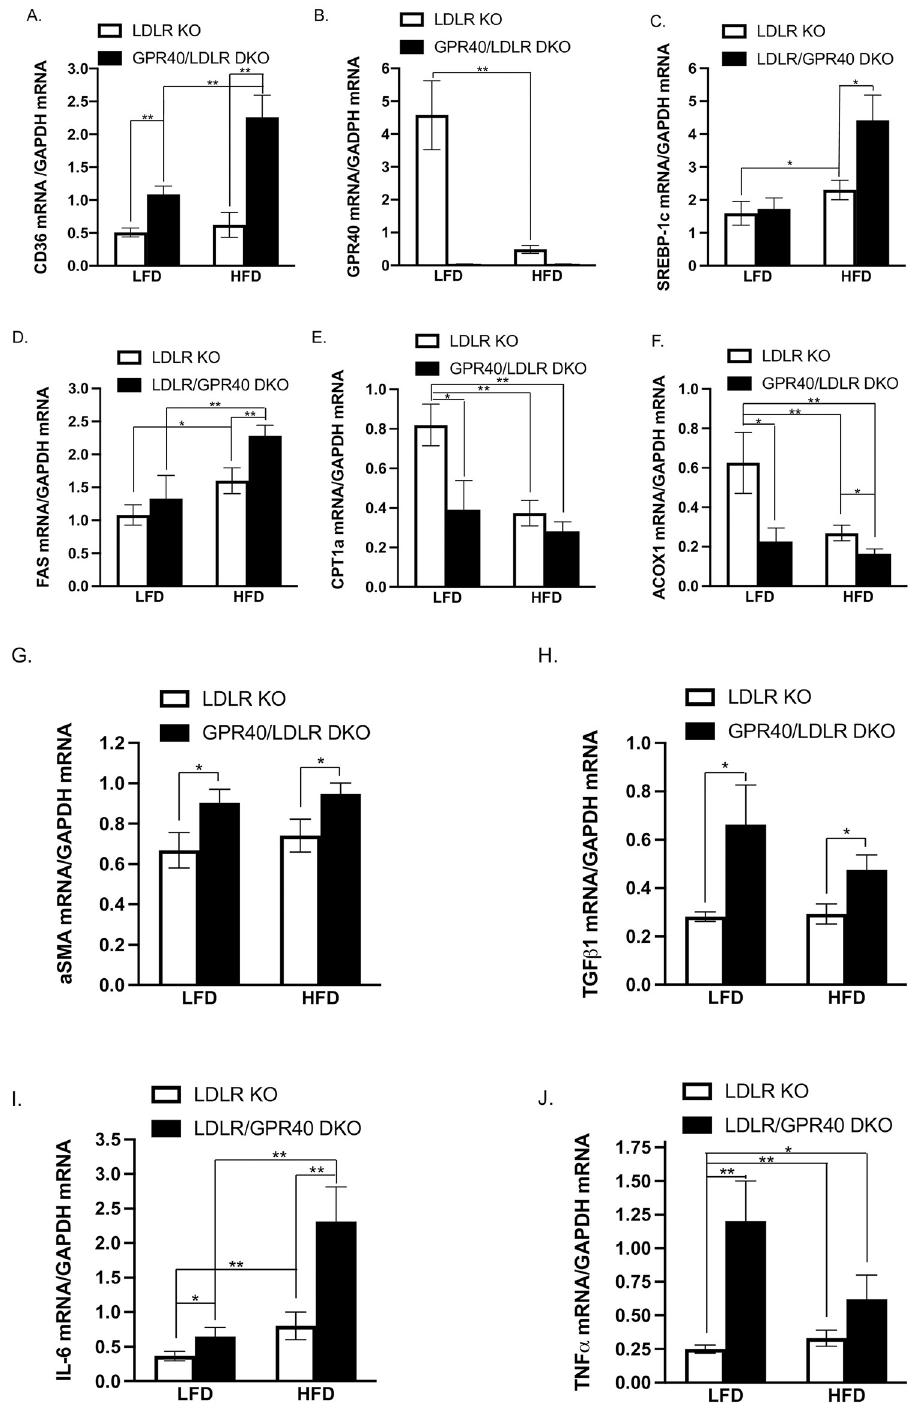
Fig 6. GPR40 KO is associated with upregulation of CD36 and genes involved in lipogenesis. After feeding mice an LFD or HFD for 20wk, RNA was isolated from livers of all mice and the following mRNA was quantified using real- time PCR and normalized to GAPDH mRNA: (A) CD36; (B) GPR40; (C) sterol regulatory element-binding protein (SREBP)-1c; (D) fatty acid synthase (FAS); (E) carnitine palmitoyltransferase 1A (CPT1a); (F) acyl-CoA oxidase (ACOX)1; (G) alpha smooth muscle actin (aSMA); (H) transforming growth factor beta 1 (TGF β 1); (I) IL-6; (J) tumor necrosis factor alpha (TNF α ). The data are presented as means ± SE (n = 6–8). One-way ANOVA and Student’s t test were used for the statistical analysis. � p < 0.05; �� p < 0.01. LFD, low-fat diet; HFD, high-fat diet; KO, knockout; DKO, double